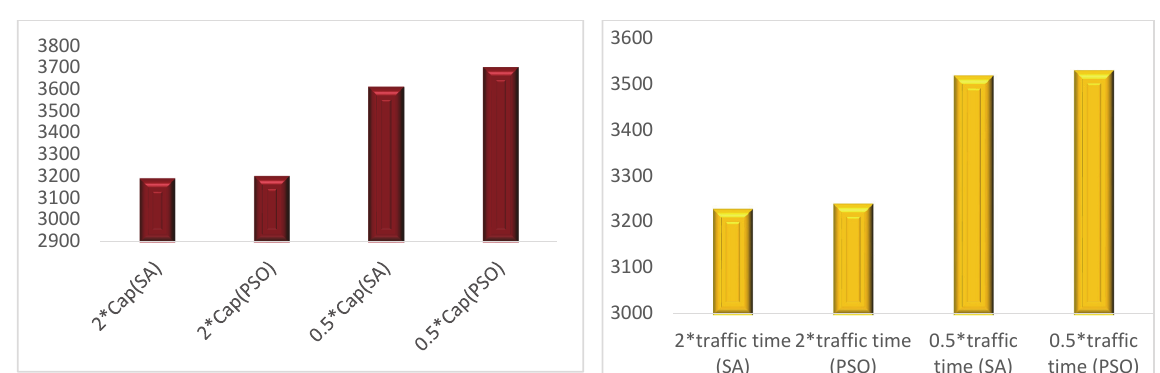
Fig. 6. OFV Comparison of test problems